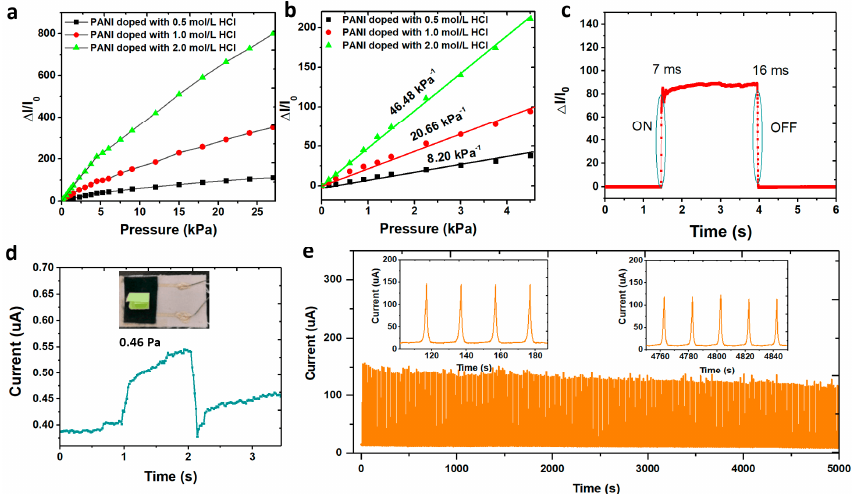
Figure 5. Evaluation of electromechanical performances. ( a ) Relative current change–pressure relationship of three pressure sensors with different concentrations of HCl; ( b ) Magnified curves from 0 to 4.5 kPa, showing its superior linearity over a large detection range; ( c ) Response/release time of the device; ( d ) Current response to the loading and removal of a small piece of paper on the PANI-based pressure sensor, corresponding to a pressure of only 0.46 Pa; ( e ) The cycling test of the sensor under 5 kPa pressure.